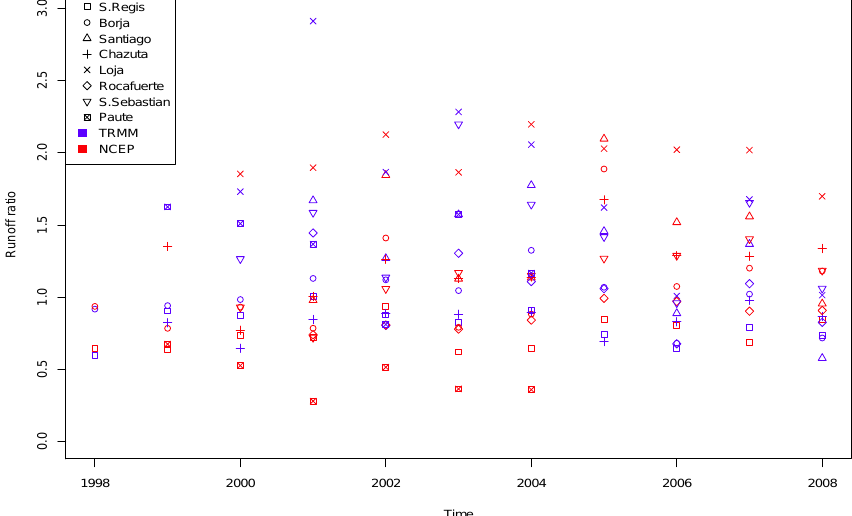
Fig. 3. Temporal and spatial trends in the runoff ratios calculated using observed streamflows and TRMM and NCEP precipitation. The expected value for humid tropical regions is between 0.6 and 0.7.